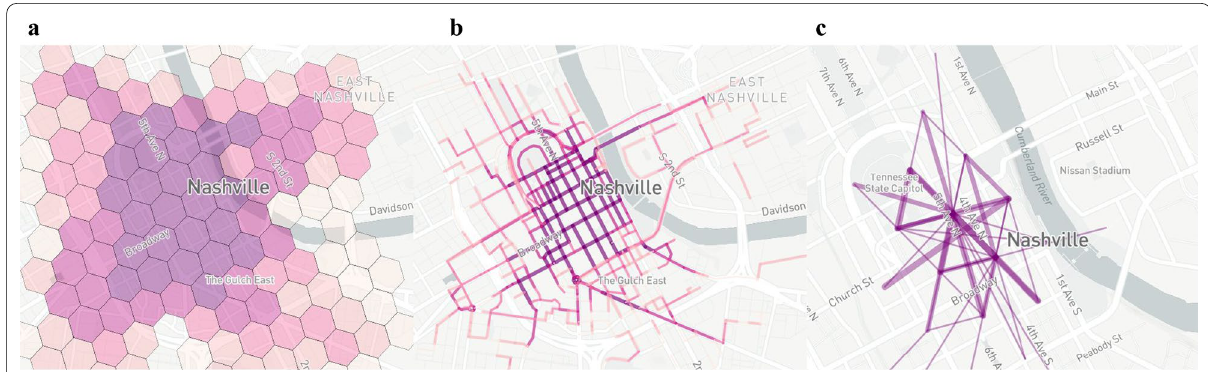
Fig. 2 Geographic binning performed per H3 hexagon ( a ), road segment ( b ), and origin/destination pair between H3 hexagon’s centroids ( c